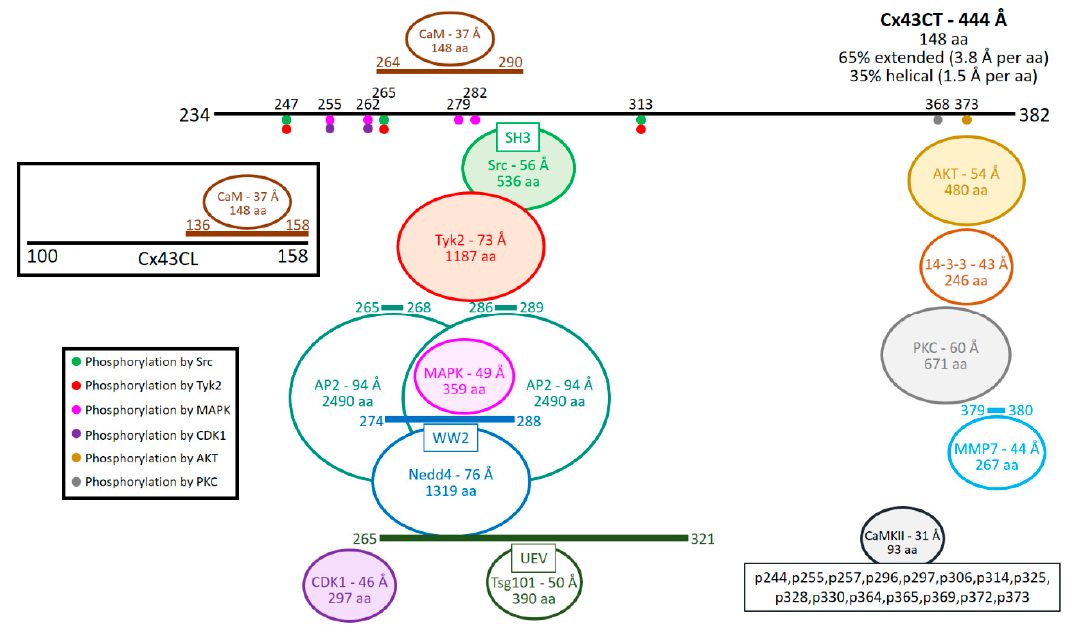
Figure 2. Protein partners that directly interact with the Cx43 CT and CL domains to impede intercellular communication. The black lines represents Cx43CT domain residues 234–382 and Cx43CL domain residues 100–158. Provided for each Cx43 CT and CL protein partner (circle) is its diameter (in Å) as estimated from their molecular weight, and number of amino acids (aa), and the Cx43CT residues affected as a result of the interaction (lines). If the protein partner is a kinase, the Cx43CT residues affected are labeled on the Cx43CT (circle). Abbreviations are as follows: Calmodulin (CaM), Src homology 3 domain (SH3), Tyrosine kinase 2 (Tyk2), Mitogen-activated protein kinase (MAPK), Neural precursor cell expressed developmentally down-regulated protein 4 (Nedd4), Cyclin-dependent kinase 1 (CDK1), Tumor susceptibility gene 101 protein (Tsg101), Ubiquitin E2 variant domain (UEV), Protein kinase B (AKT), Protein kinase C (PKC), matrix metalloproteinase-7 (MMP7), and Ca 2+ /calmodulin-dependent protein kinase II (CaMKII). Kinases have been highlighted (shaded circle).